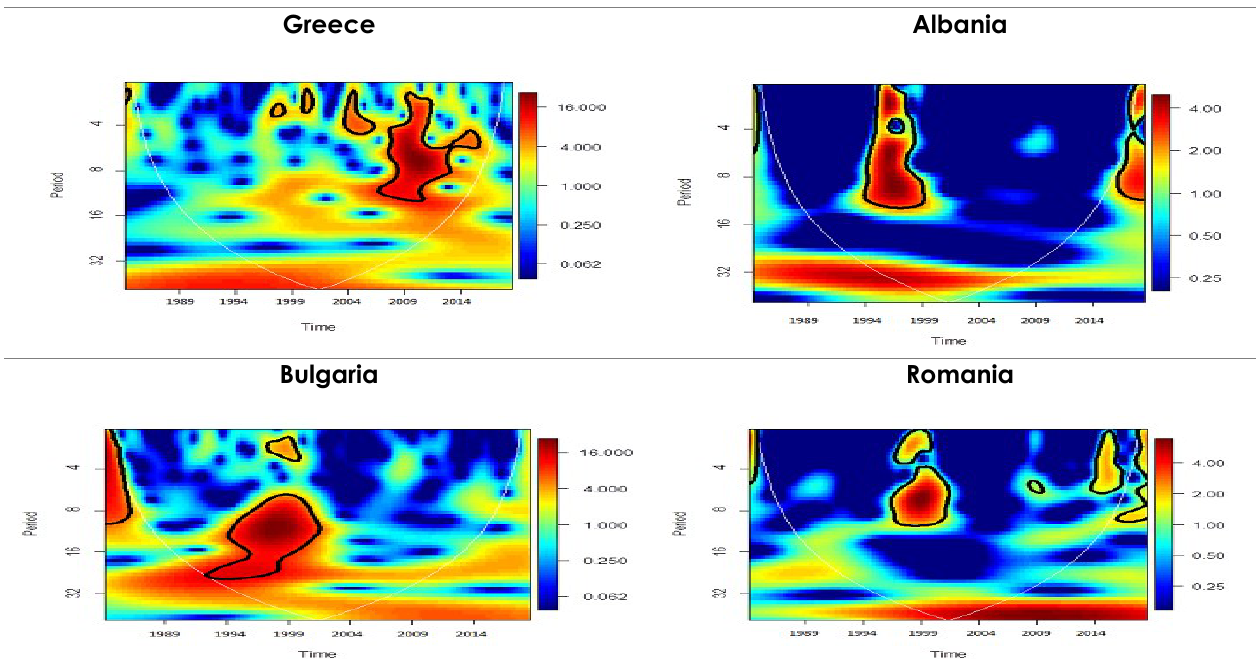
Figure 2. Wavelet Power Spectrum for Financial Risk. Source: Author using Political Risk Group (2019)